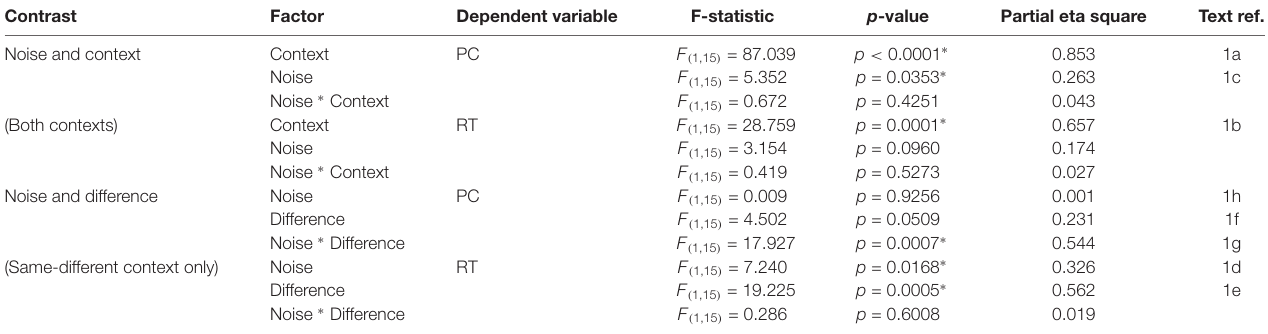
TABLE 1 | Behavioral performance statistics for context (Fast-slow, Same-different), noise (Regular, Noisy), and difference (Different, Same). Contrast Factor Dependent variable F-statistic p -value Partial eta square Text ref.